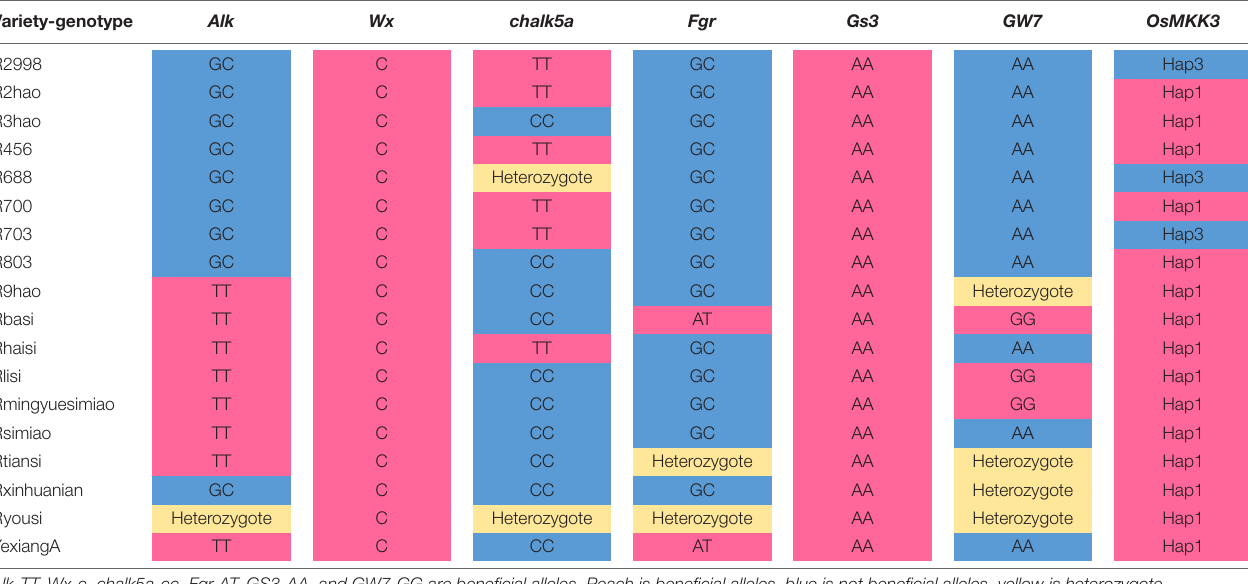
TABLE 2 | Genotype of restorer lines.